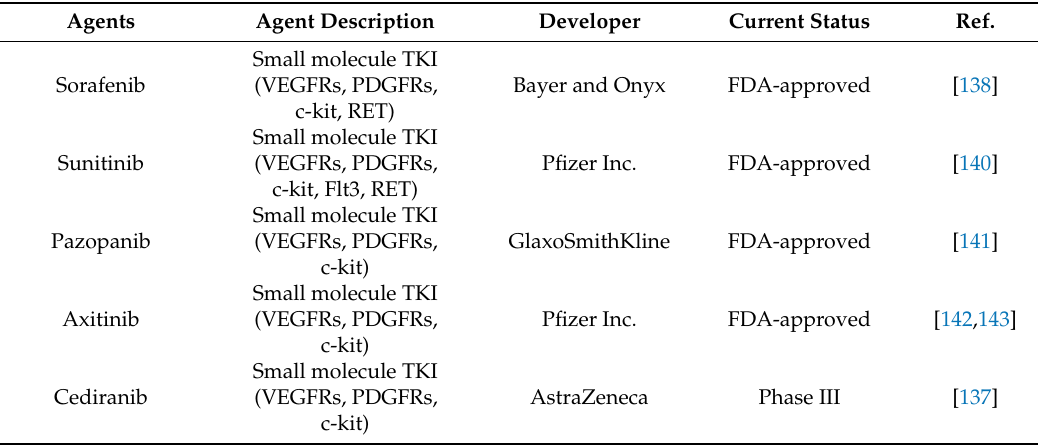
Table 2. Therapeutic agents for the inhibition of VEGF-C/VEGFR3